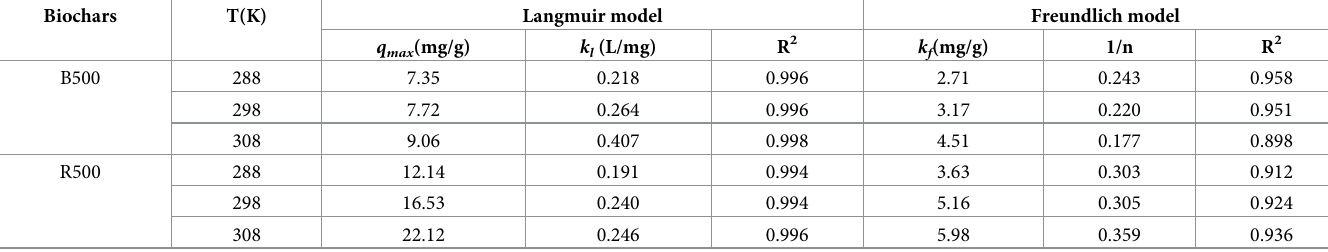
Table 3. Langmuir and Freundlich models parameters for BR46 adsorption on biochars. Biochars T(K) Langmuir